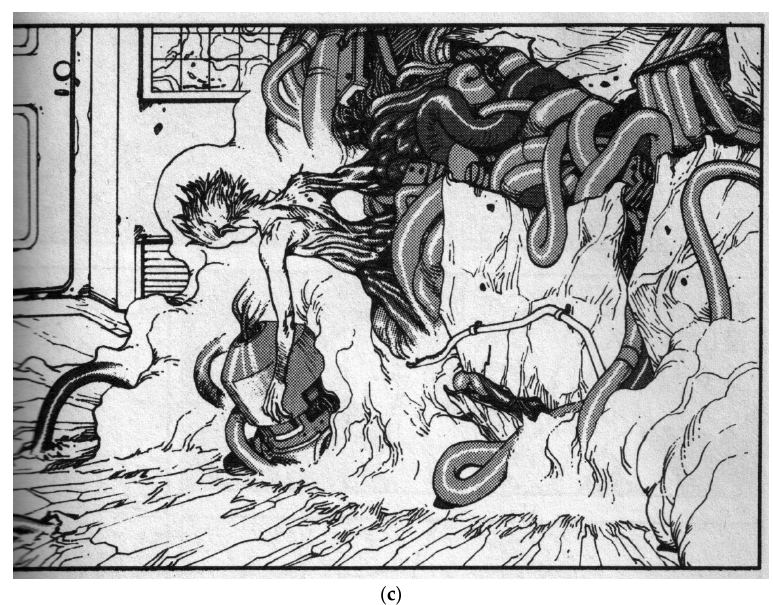
Figure 1. ( a ) panel from Katsuhiro Ō tomo, Akira (K ō dansha), vol. 4 (1987), p. 106; ( b ) vol. 5 (1990), p. 263; ( c ) vol. 5 (1990), p. 352.